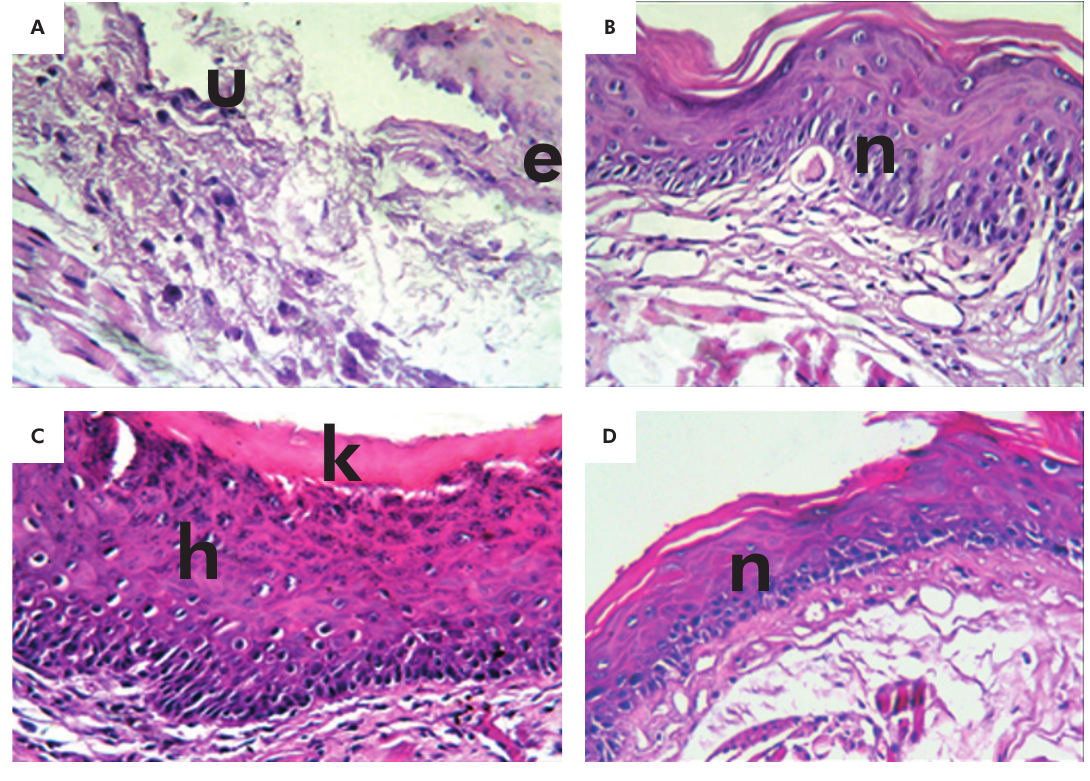
Figure 3. photomicrograph of the lower lip at the 7th day post-ulceration of (A) group R, (B) group AV, (C) group NS, and (D) group AV+NS showing ulcerated epithelium (u), retained epithelium (e), normal epithelium with thin keratin layer (n), hyperplastic epithelium (h), and hyperkeratosis (k). H&E ×400.